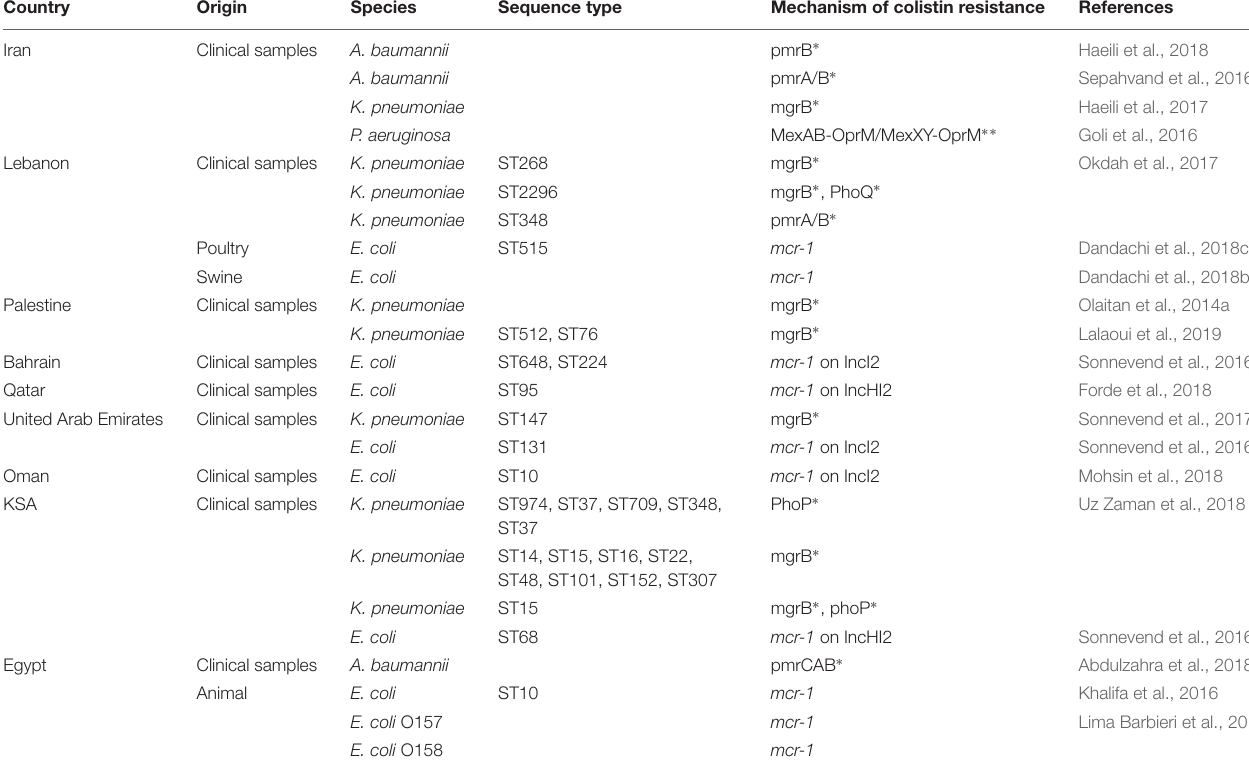
TABLE 3 | Mechanisms of colistin resistance described in GNB in the Middle